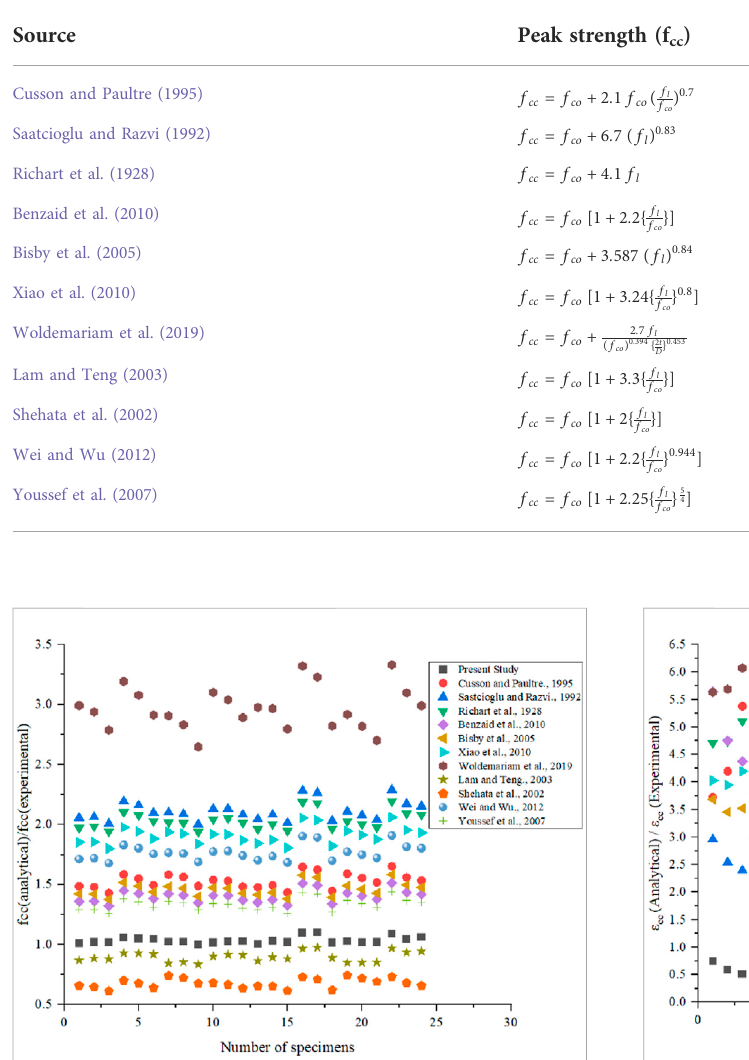
TABLE 4 Models used for calculation of f cc and ε cc .